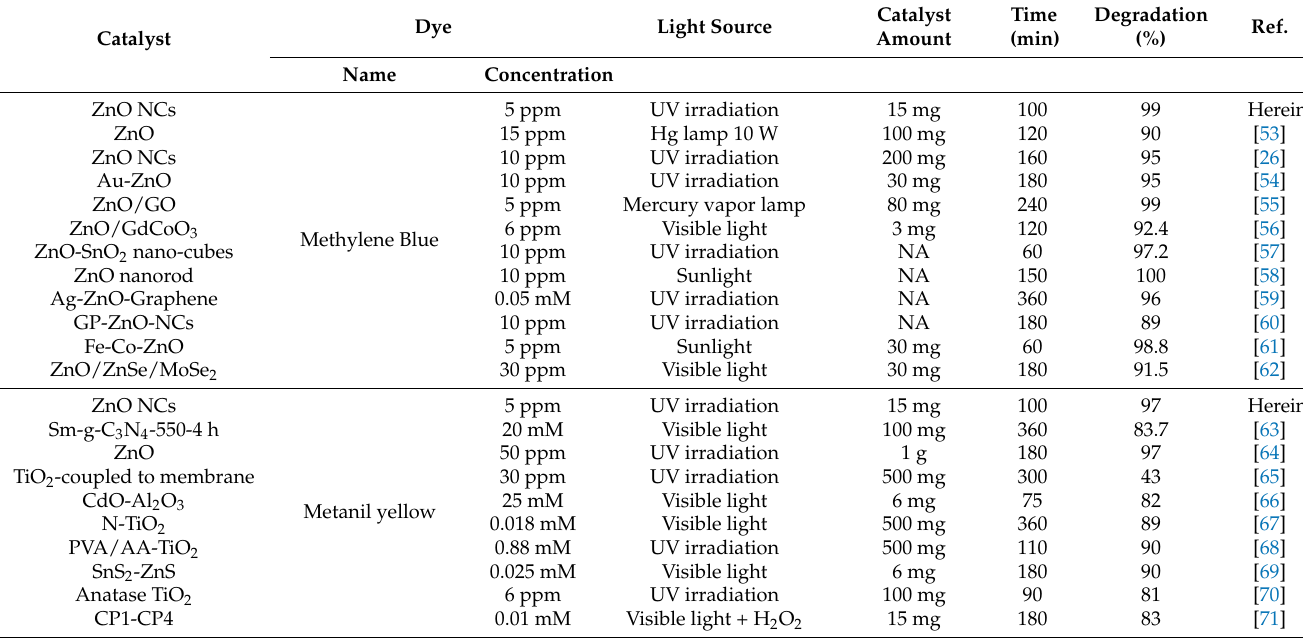
Table 1. Comparative data of photocatalytic degradation of organic dyes using ZnO nanoparticle- based